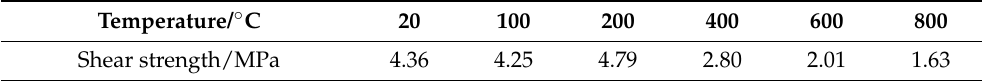
Table 7. Shear strength of concrete after different heated temperatures. Temperature/ ◦